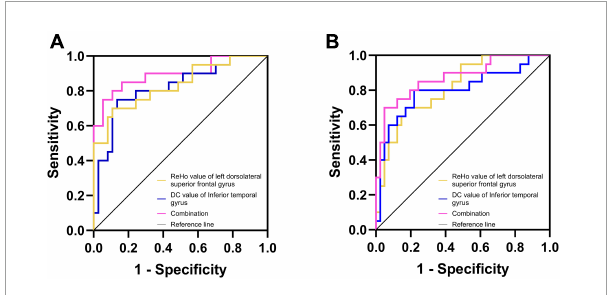
FIGURE5 Diagnosis and differentiation of DPD based on ROC analysis. (A) ROC curve showing the classification of DPD and NDPD; (B) ROC curve showing the classification of DPD and